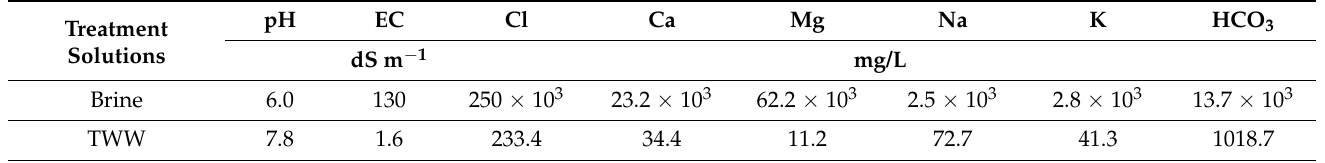
Table 1. Electrical conductivity (EC), pH values, and the concentrations of various ions in the studied treatment solutions: brine from the Dead Sea and treated wastewater (TWW) from the Taoz wastewater treatment plant. Treatment